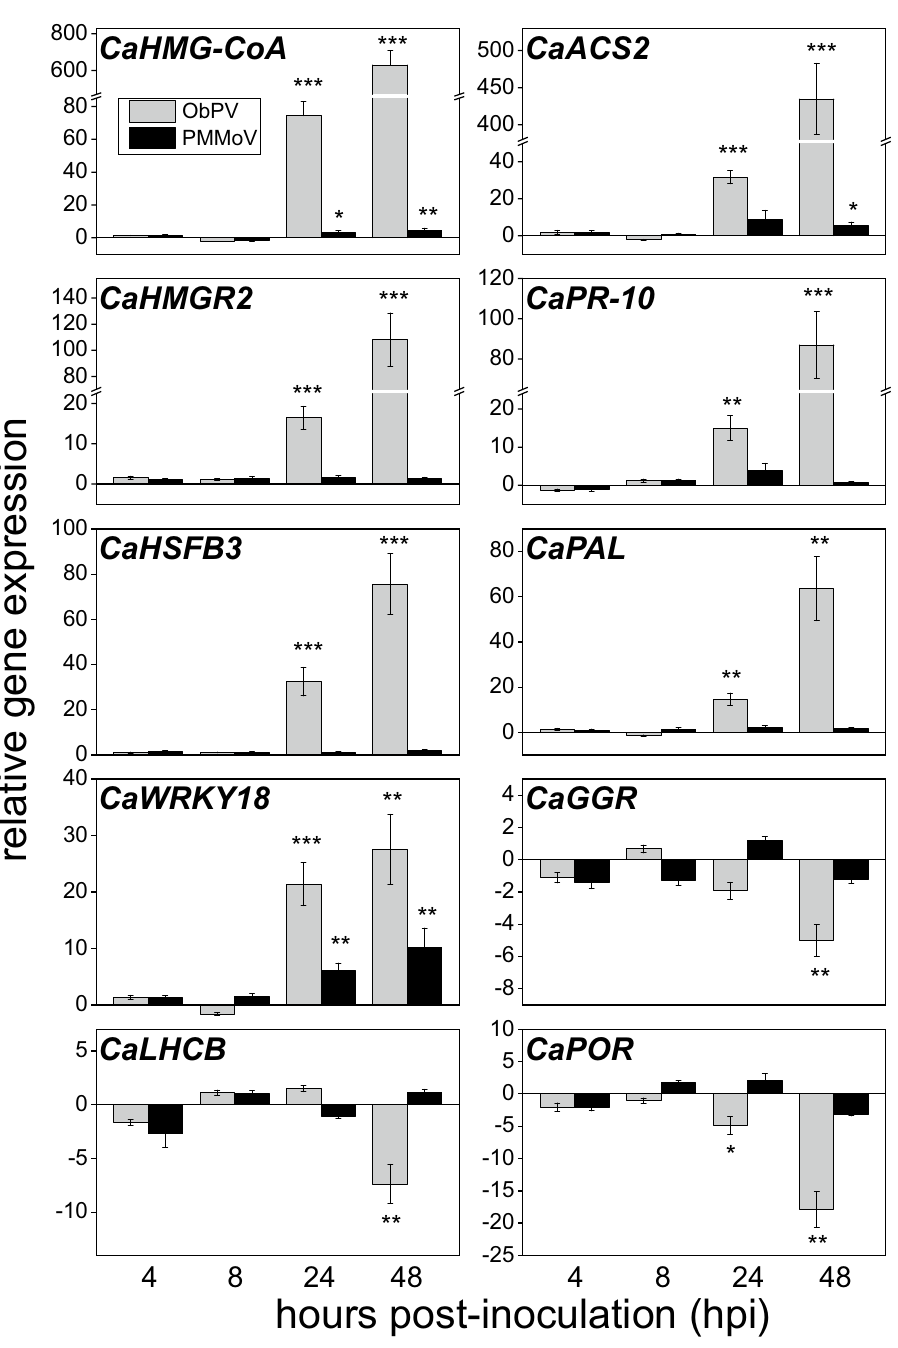
Figure 6. Changes in the relative expression of ten selected pepper genes in ObPV- and PMMoV-inoculated leaves analyzed by real-time RT-qPCR. The ten selected genes and their GenBank accession numbers were the following: hydroxymethylglutaryl-CoA synthase ( CaHMG-CoA/ XM_016702295), 1-aminocyclopropane- 1-carboxylate synthase ( CaACS2/ XM_016682648), 3-hydroxy-3-methylglutaryl-coenzyme A reductase ( CaHMGR2/ XM_016702348), pathogenesis-related protein 10 ( CaPR-10 /XM_016710983), heat shock transcription factor ( CaHSFB3/ XM_016688343), phenylalanine ammonia-lyase ( CaPAL /NM_001324603), WRKY transcription factor 18-like (Ca WRKY18 /XM_016726661), geranylgeranyl diphosphate reductase ( CaGGR /XM_016707759), chlorophyll a-b binding protein 1B ( CaLHCB/ XM_016700776) and protochlorophyllide reductase ( CaPOR/ XM_016689752). Expression values of these genes were normalized to those of the reference gene ubiquitin-conjugating enzyme 3 ( CaUBC3 , XM_016720449) and then related to mock-inoculated leaf samples at each time point according to the method of Livak and Schmittgen (2001) 97 . Gray and black columns represent ObPV and PMMoV inoculated leaves, respectively. Mean values of three independent experiments are shown ± SD. The symbols *, ** and *** show significant differences between mock and virus-inoculated plants at P < 5%, < 1% and < 0.1%,